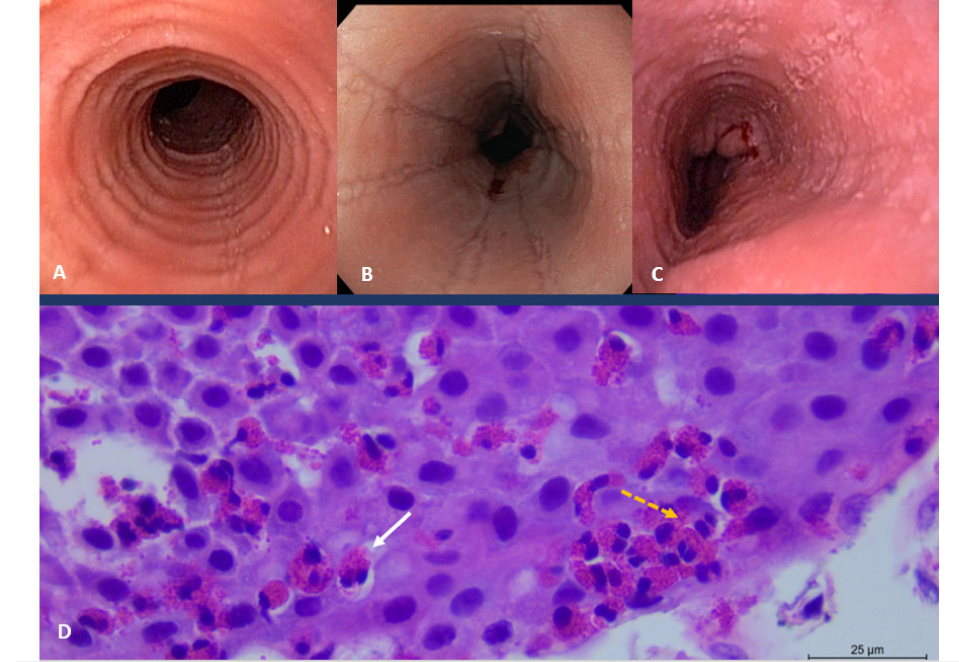
Figure 2. Eosinophilic esophagitis. The figures show the endoscopic appearance and typical histo- logic features of the disease. ( A ). Circular rings simulating the appearance of a trachea; ( B ). Linear narrows, ( C ). Erosions can be seen in the esophagus. ( D ). H&E esophageal mucosa showing numer- ous intraepithelial eosinophils (>15 per high-power field) (orange dashed arrow) with eosinophilic microabscesses (white solid arrow). Courtesy of Santos Santolaria, M.D. Ph.D. Unity of Gastroin-